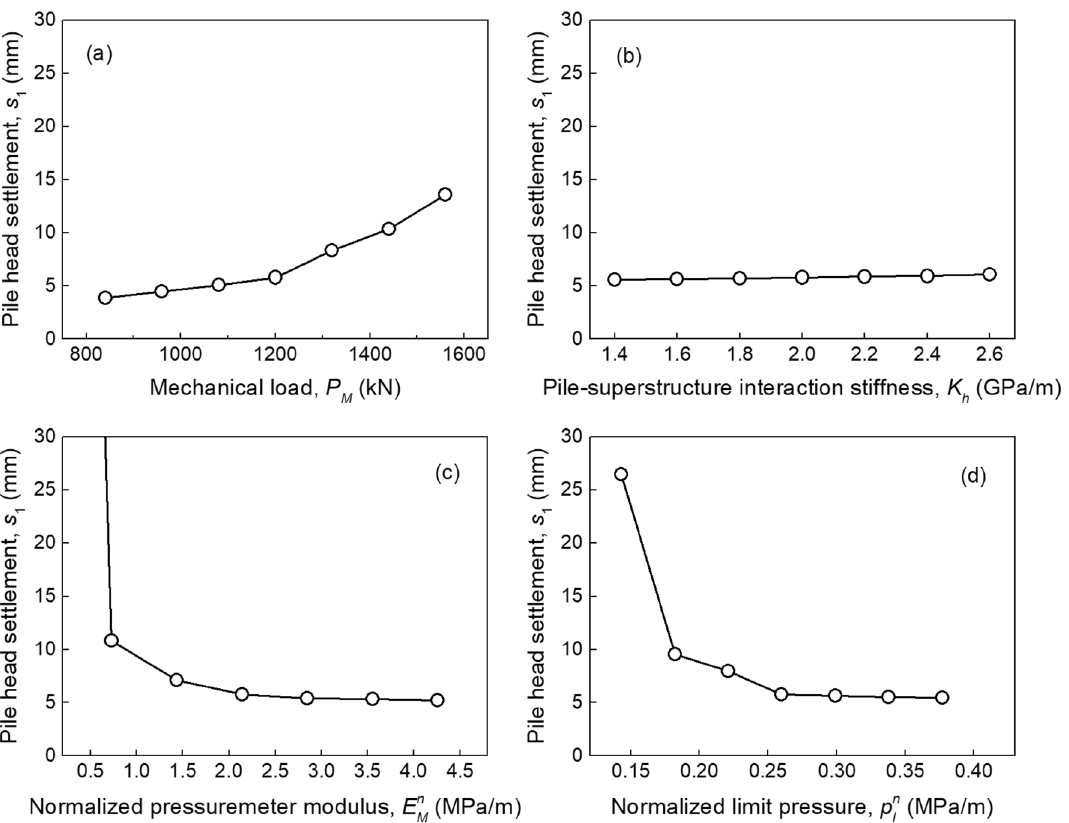
Figure 5. Effect of key parameters on the pile head settlement: ( a ) P M ; ( b ) K h ; ( c ) E n M ; ( d ) p n l .